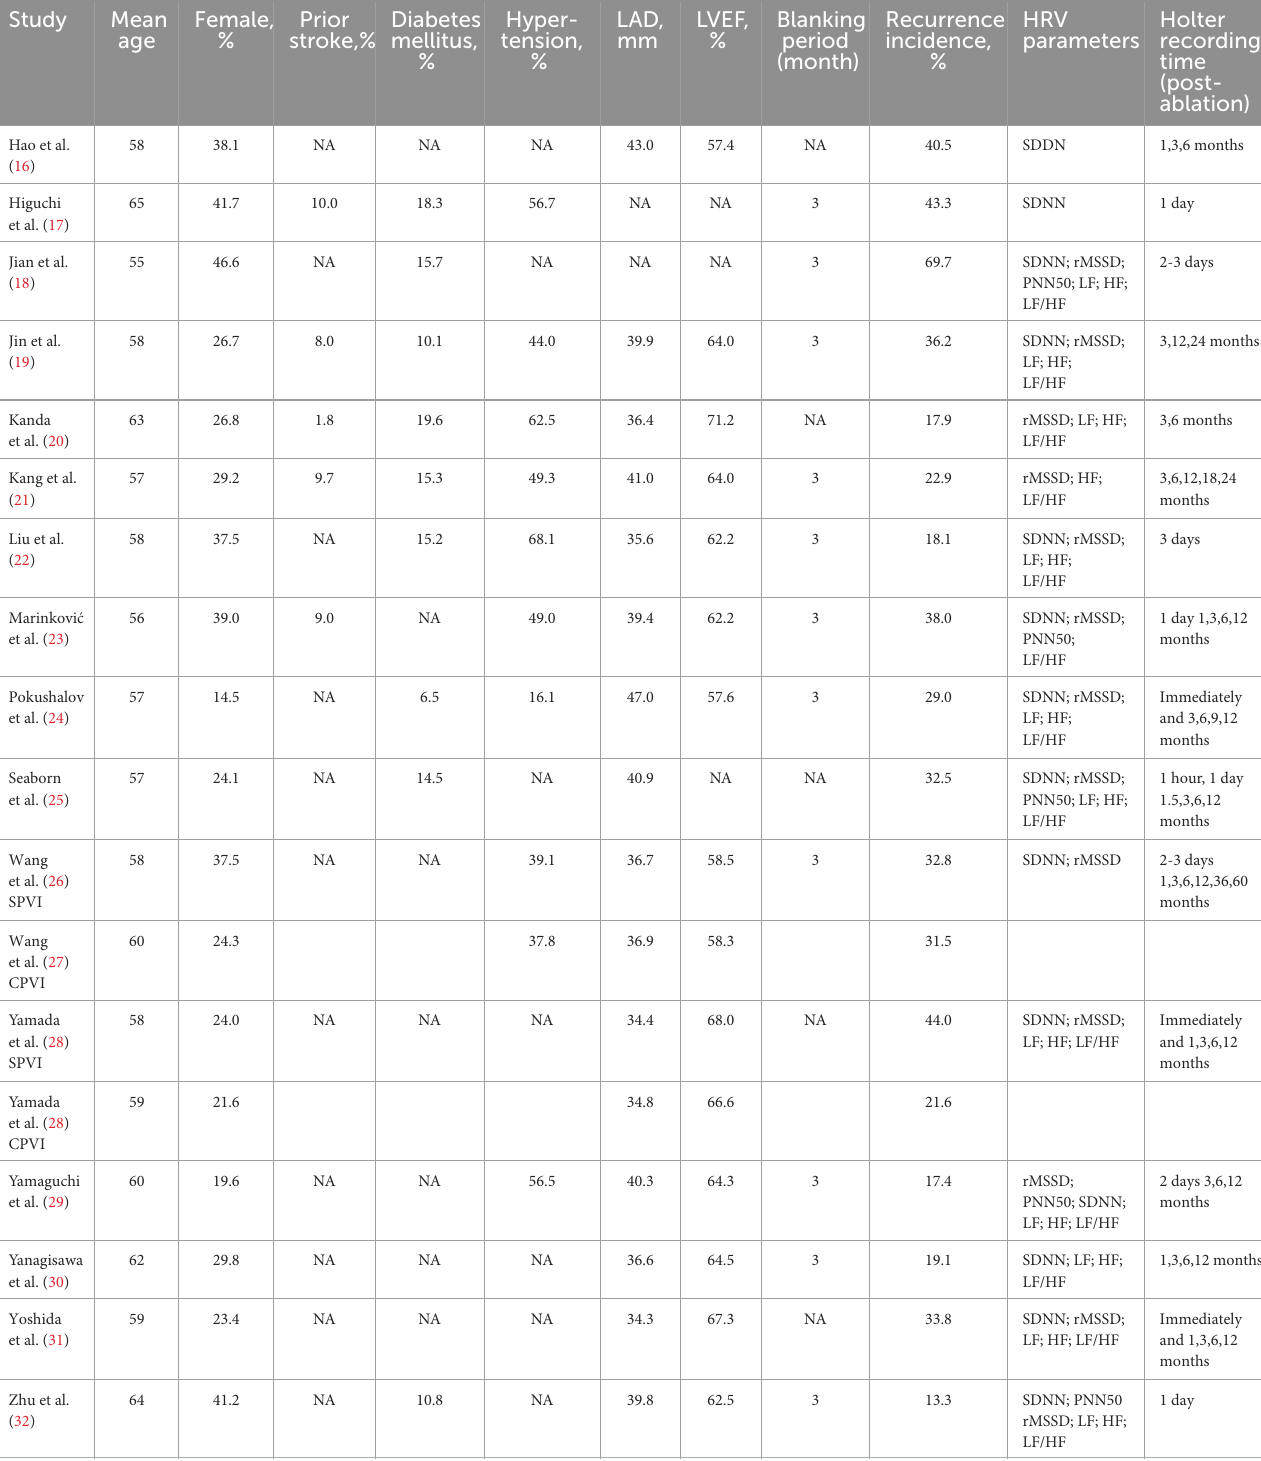
LVEF, left ventricular ejection fraction, LAD, left atrial diameter; AF, atrial fibrillation; N/A, not available; HF, high frequency; LF, low frequency; SDNN, standard deviation of all NN intervals; PNN50,percentageofadjacentNNintervaldifferences >